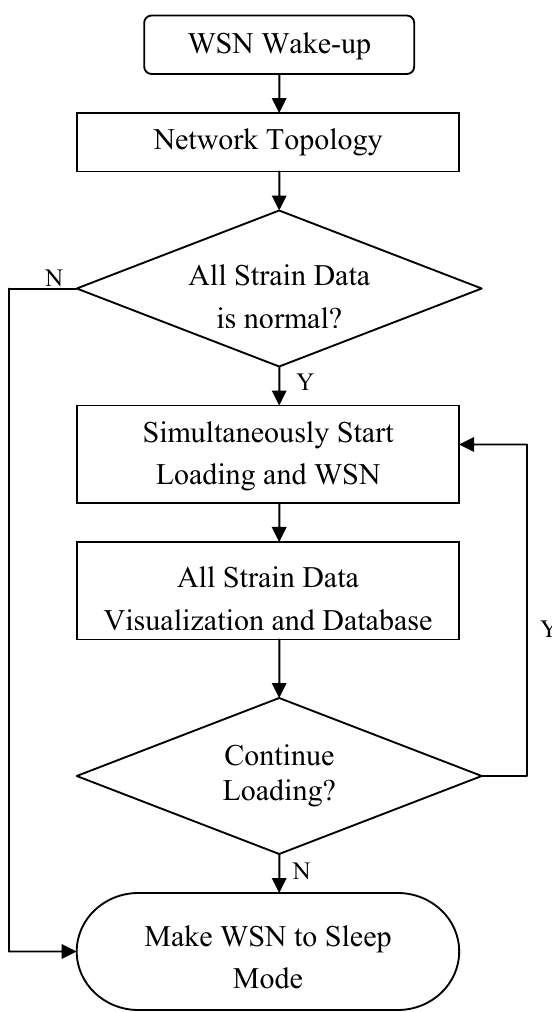
Figure 10. The flow chart for the WSN application layer